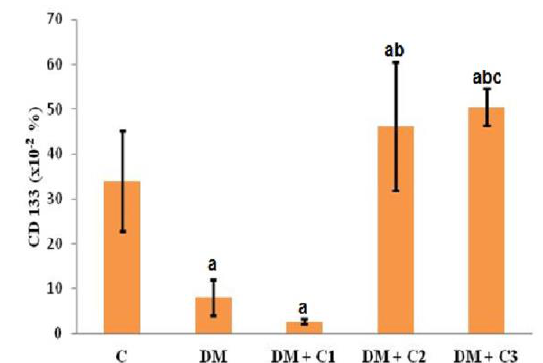
Figure 2. The CD133 + count in each experimental groups. Values are presented as mean ± SD; a P < 0.05 in comparison with control (C) group; b P < 0.05 in comparison with diabetes mellitus (DM) group; c P < 0.05 in comparison with